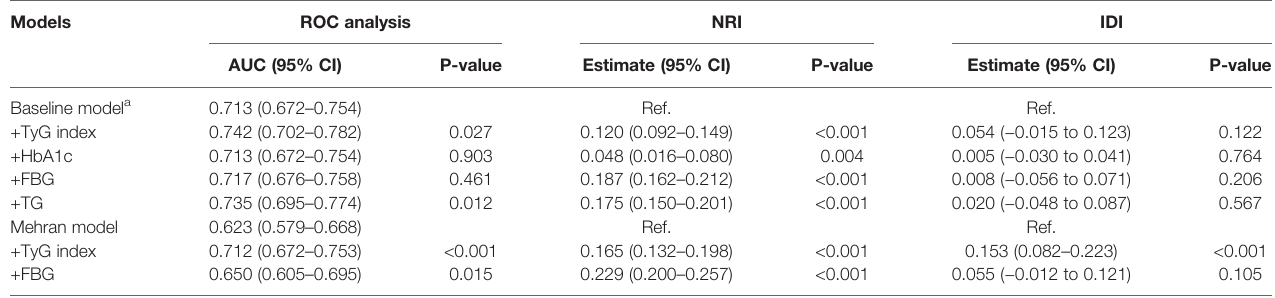
TABLE 5 | Incremental effect of TyG index in predicting CIN.